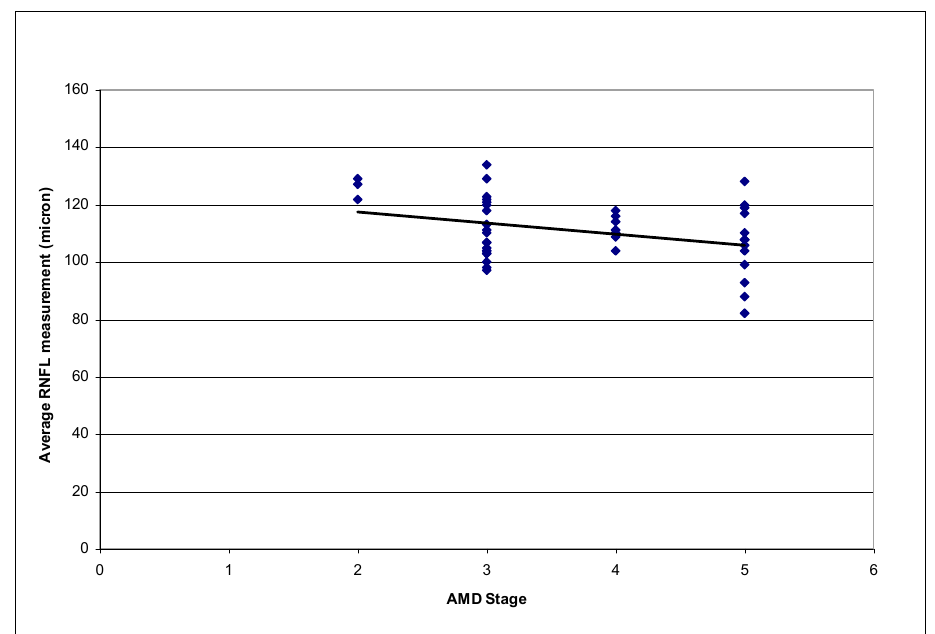
Figure 2. Correlation between Average RNFL measurements by Spectral-domain OCT and AMD stages. ( p = 0.049, R 2 = 0.117; OCT: Optical coherence tomography; AMD: Age-related macular degeneration; RNFL: Retinal nerve fiber layer.).